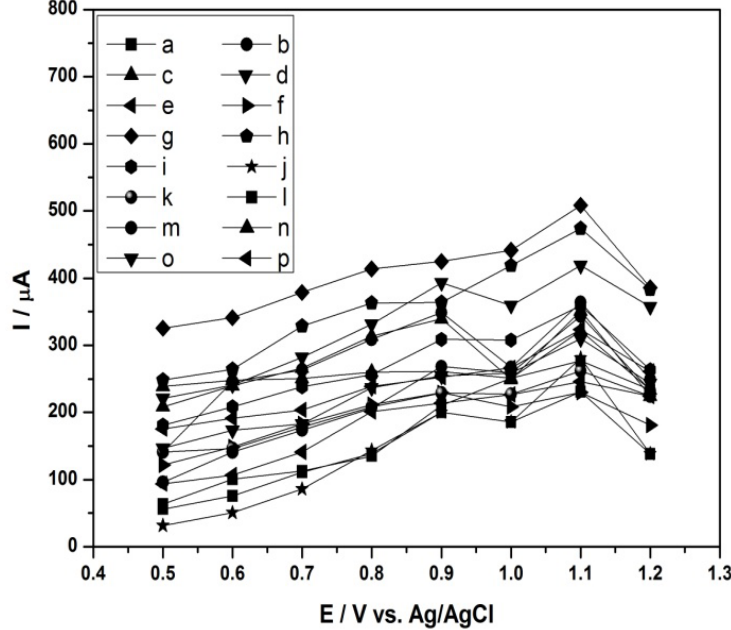
Figure 3. Hydrodynamic voltammograms of a 24 mg·L − 1 standard of a :